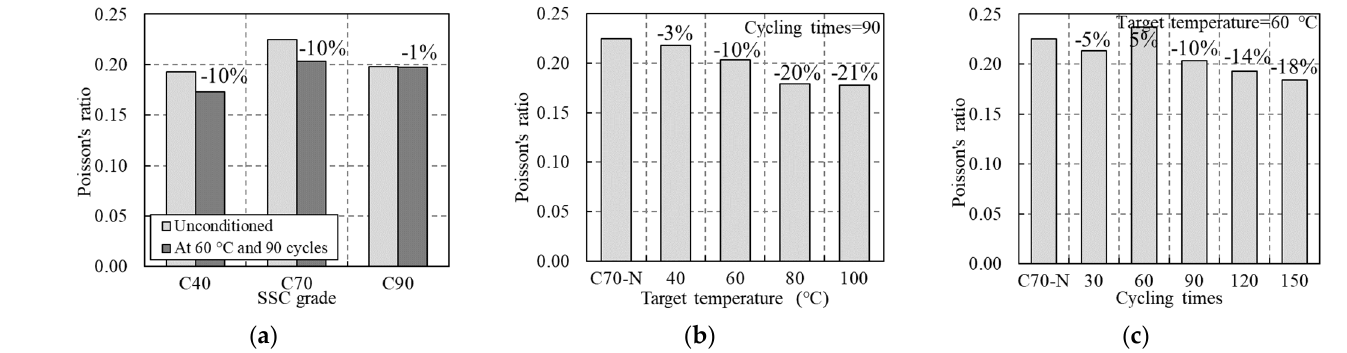
Figure 11. Poisson’s ratio of SSC: ( a ) effects of SSC grade; ( b ) effects of target temperature; ( c ) effects of cycling times.